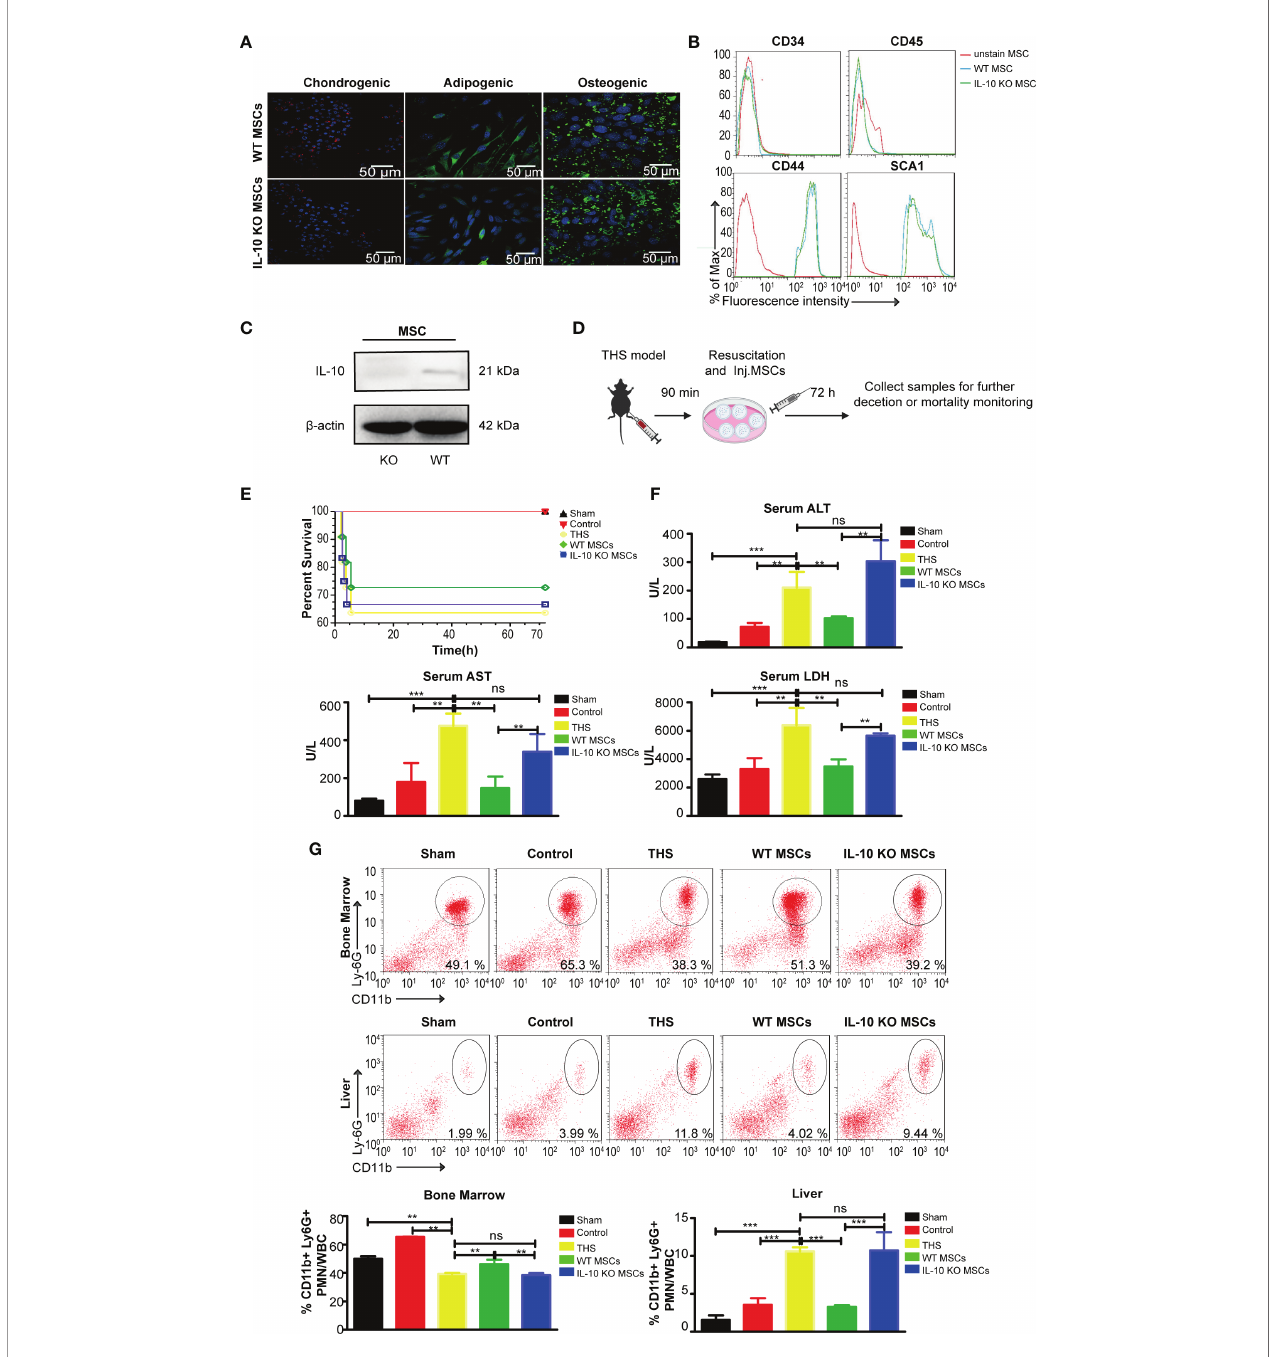
FIGURE 1 | WT MSCs alleviate THS-induced hepatic injury in mice, but IL-10 KO MSCs do not show a protective effect. MSCs and IL-10 KO MSCs were isolated from WT C57/B6 mice and IL-10 KO C57/B6 mice, respectively. (A) Representative confocal images showing the adipogenic (FABP4), chondrogenic (Collagen II) and osteogenic (Ostepontin) ability of MSCs and IL-10 KO MSCs. Scale bars, 50 m m. (B) Flow cytometry analysis of the surface markers (CD44, SCA1, CD34, CD45) on WT MSCs and IL-10 KO MSCs. (C) Western blotting analysis of IL-10 expression in the indicated MSCs (The amount of protein loaded in this study was 20 m g). (D) Schematic diagram of the THS model treated by WT MSCs or IL-10 KO MSCs. (E) The survival rates of the sham, control, THS, WT MSCs and IL-10 KO MSCs treatment groups; Survival was monitored for 72h after injury (n=10 – 12). (F) Serum LDH, ALT and AST levels in peripheral blood from the indicated groups (n=3 – 5). (G) Flow cytometry analysis of CD11b + Ly6G + neutrophils in bone marrow and livers in the indicated groups (n=3 – 5). **P < 0.01, ***P < 0.001; ns, not signi fi cant. All data are shown as the means ±